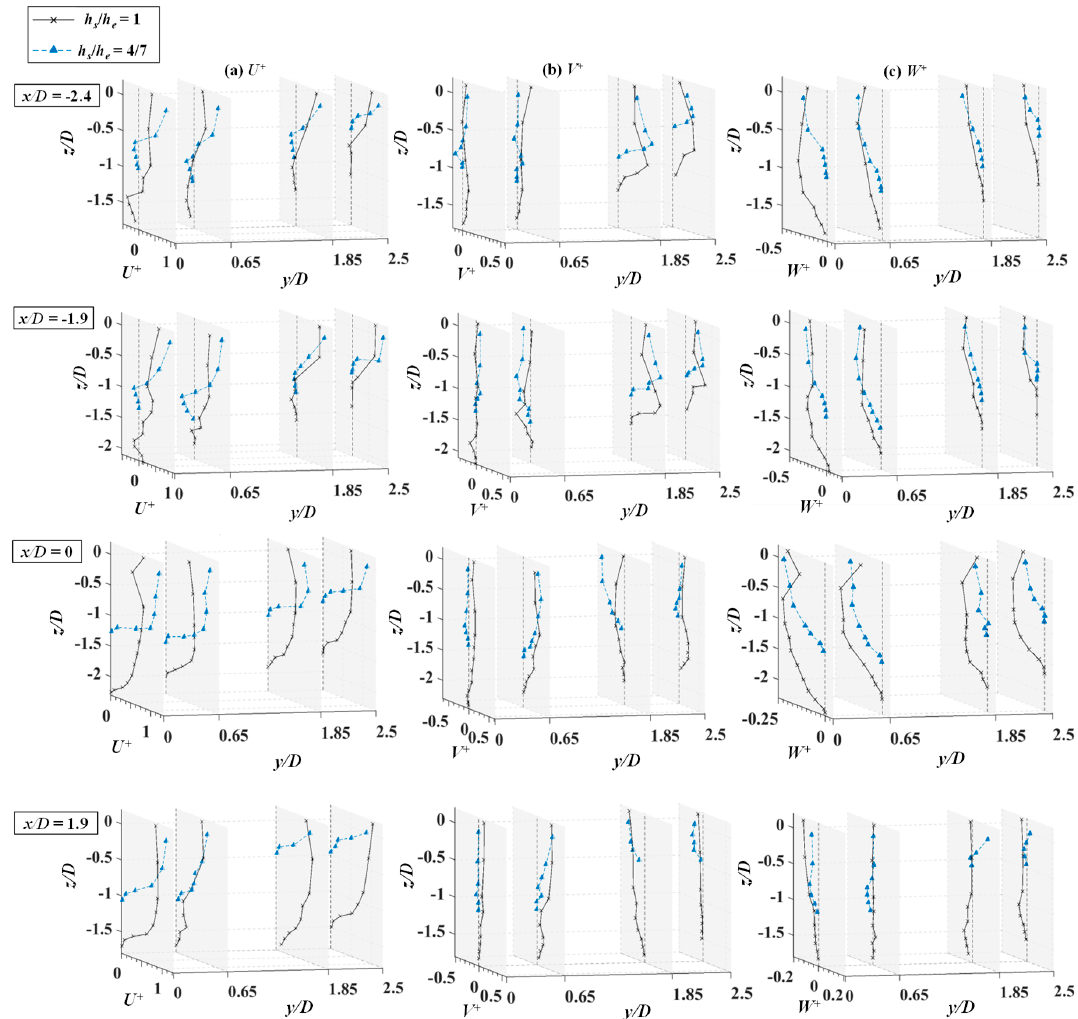
Figure 15. Comparison of the detailed measurements for intermediate and equilibrium scour holes at x / D = − 2.4 and 1.9: ( a ) U + ; ( b ) V + ; ( c ) W + .